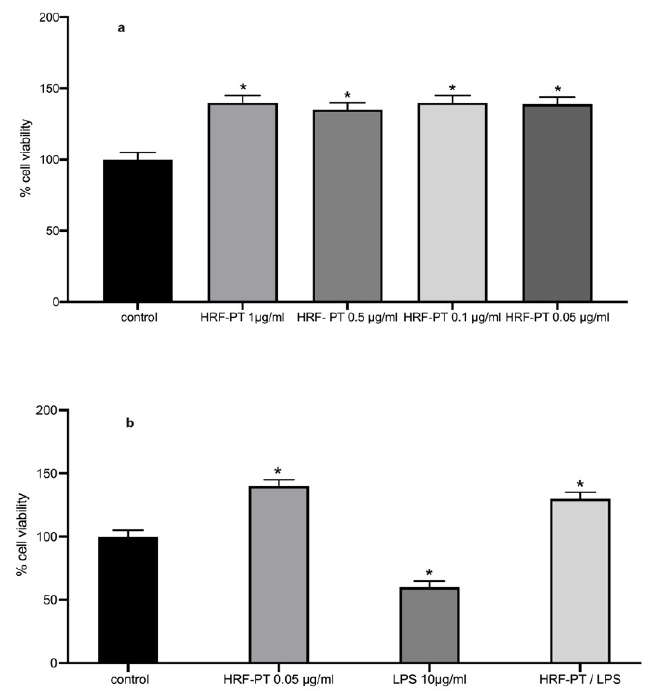
Figure 1. Cell viability (%) assessment based on MTT assay expressed as mean ± SEM for ( a ) control (untreated NHDF cells), NHDF cells treated with different concentrations of HRF-PT (0.05–1 μ g/mL). Cell viability is increased with the addition of HRF-PT in different concentrations (0.05–1 μ g/mL) compared to control ( p < 0.05); ( b ) control (untreated NHDF cells), NHDF cells treated with different concentrations of HRF-PT (0.05 μ g/mL), NHDF cells under LPS (10 μ g/mL) treatment (LPS 10 μ g/mL), NHDF cells under LPS treatment with HRF-PT (0.05 μ g/mL) (HRF-PT/LPS). Cell viability is increased with the addition of HRF-PT (0.05 μ g/mL) under or without LPS treatment ( p < 0.05). * p < 0.05 significantly different from the control (ANOVA test).